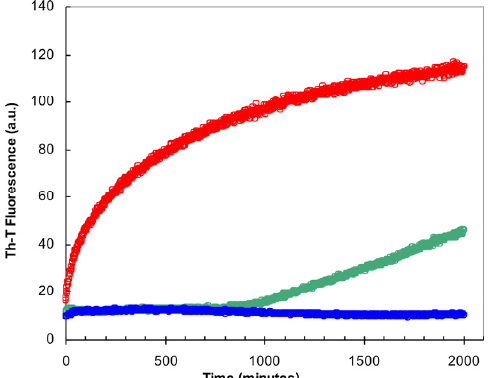
Figure 4. TFE dependence of URN1-FF aggregation kinetics. Change in Thioflavin-T (ThT) fluorescence (25 μ M) during the aggregation of URN1-FF at 100 μ M. Reactions at 0%, 15% and 25% TFE ( v / v ) concentrations are represented in red, green and blue,